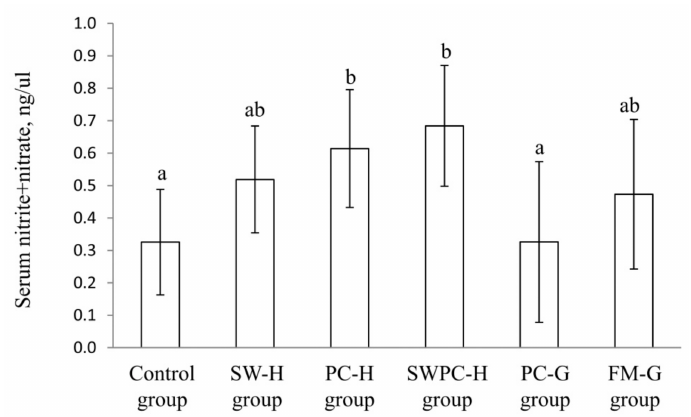
Figure 2. Serum concentration of nitrite + nitrate. Values are means, with standard error of mean represented as vertical bars. Values are shown for n = 8 in Control group, n = 5 in SW-H, and n = 6 in all other groups. Groups are compared using one-way ANOVA with LSD post hoc test when appropriate. Bars with different letters are significantly different ( p < 0.05). SW-H; stickwater from Havstrand, PC-H; presscake meal from Havstrand, SWPC-H; stickwater + presscake meal from Havstrand, PC-G; presscake meal from Granit, FM-G; fillet meal from